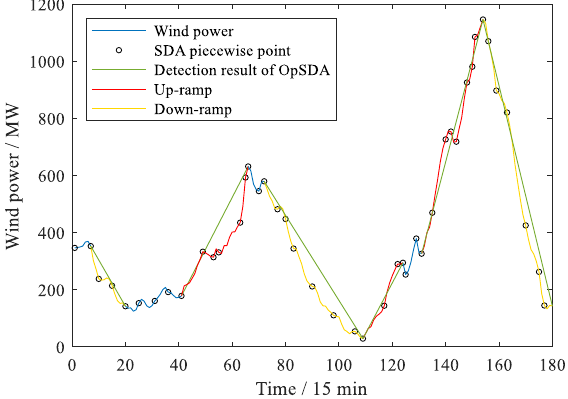
Figure 4. Ramp detection result based on OpSDA.